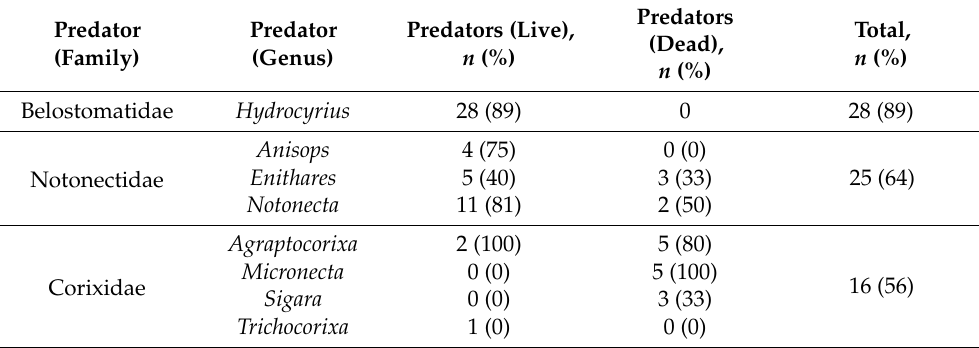
Table 2. The number ( n ) of predators tested for the presence of Anopheles mosquito DNA and the percentage (%) of the predators positive for An. arabiensis DNA. Predator Predator Predators (Family) (Genus)